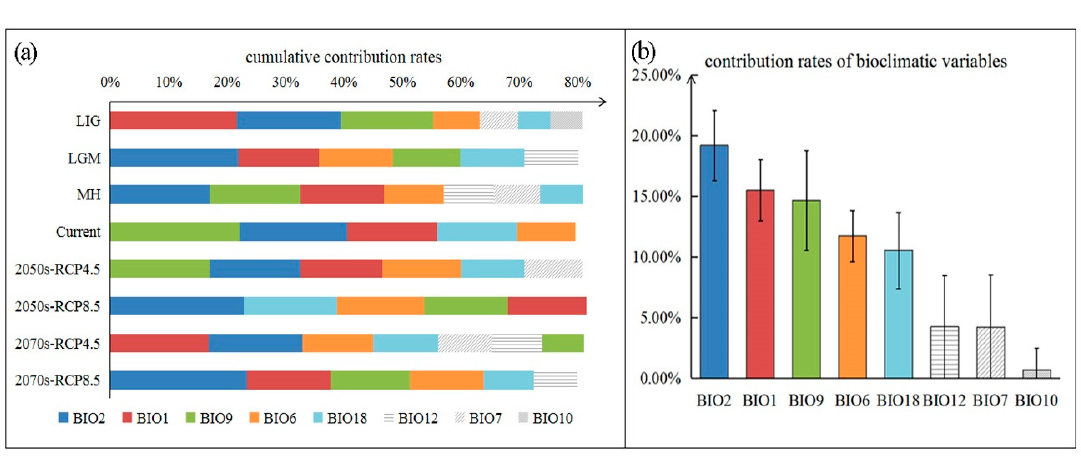
Figure 3. The key bioclimatic variables a ff ecting the growth and distribution of M. glyptostroboides . ( a ) Statistics of the bioclimatic variables with cumulative contribution rates of more than 80% under each climate scenario. They are arranged by weight in descending order. Variables common to all scenarios are defined as key bioclimatic variables, which are shown in the colored (non-textured) portion. ( b ) The average contribution rate of each key bioclimatic variables in our models.